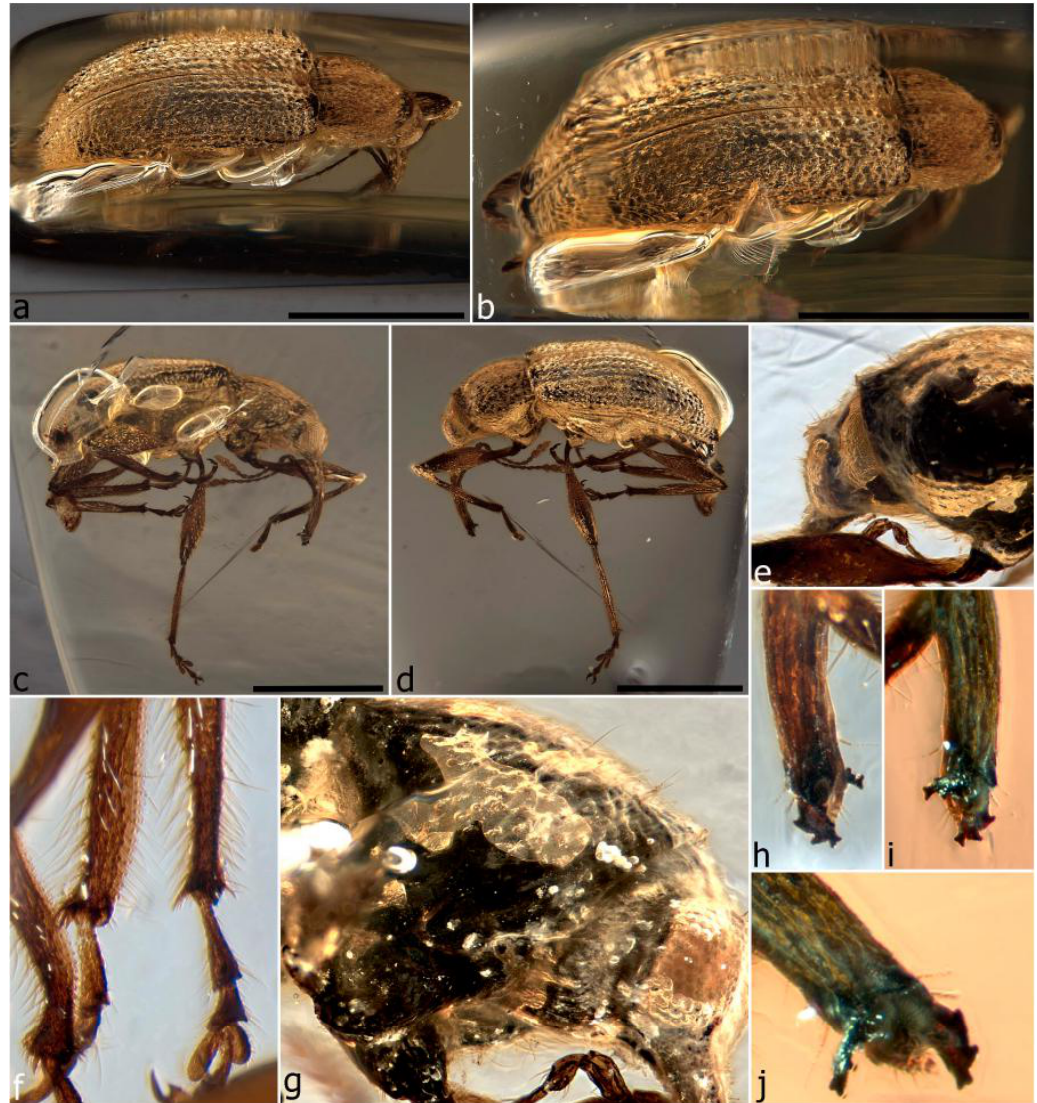
Figure 90. Louwiocis megalops sp. n., holotype. Habitus, dorsal oblique ( a ); detail of elytra, dorsal oblique ( b ); habitus, right lateral ( c ); habitus, left lateral ( d ); head and prothorax, left lateral ( e ); tibiae ( f ); head and thorax, right lateral ( g ); apex of rostrum and mandibles, left lateral ( h ); same, right oblique ( i ); same, frontal ( j ). Scale bars: 1.0 mm (a–d).